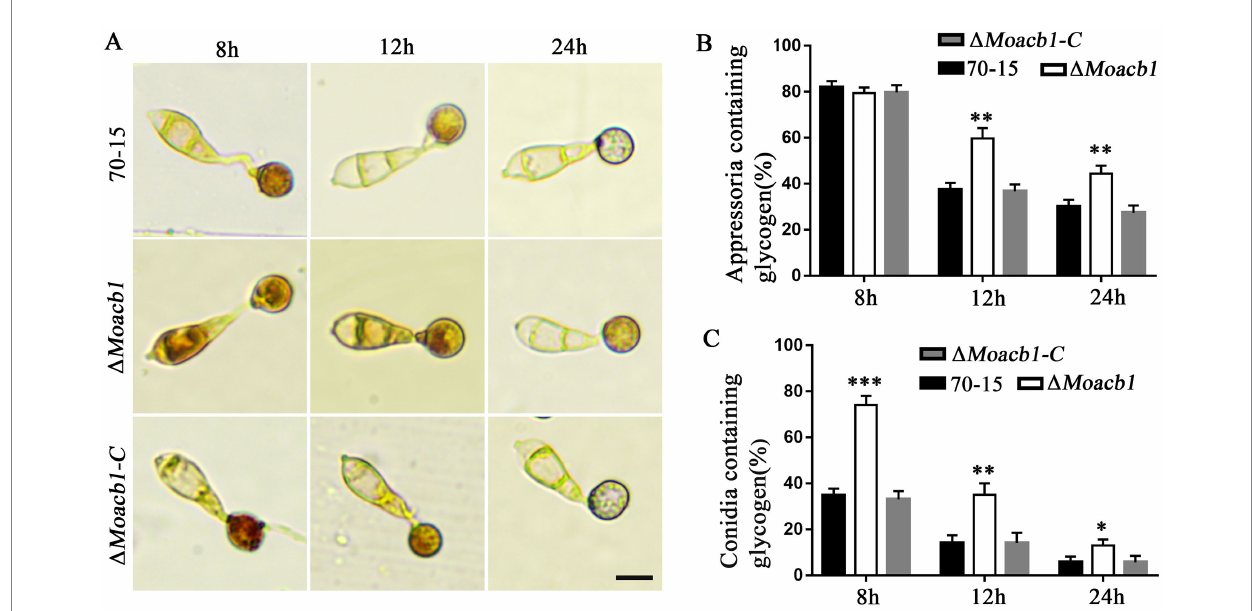
FIGURE 6 Glycogen utilization during appressorium development. (A) Distribution of glycogen during appressorium development. Samples were stained with KI/ I2 solution at different time periods, and glycogen is dark brown under the microscope. Bar, 10 μ m. (B) Proportion of appressoria containing glycogen, with standard deviation indicated by error bars. T -test was used to test for significant differences. ** p < 0.01. (C) Proportion of conidia containing glycogen, with standard deviation indicated by error bars. T -test test was used to test for significant differences. * p < 0.05, ** p < 0.01, *** p <